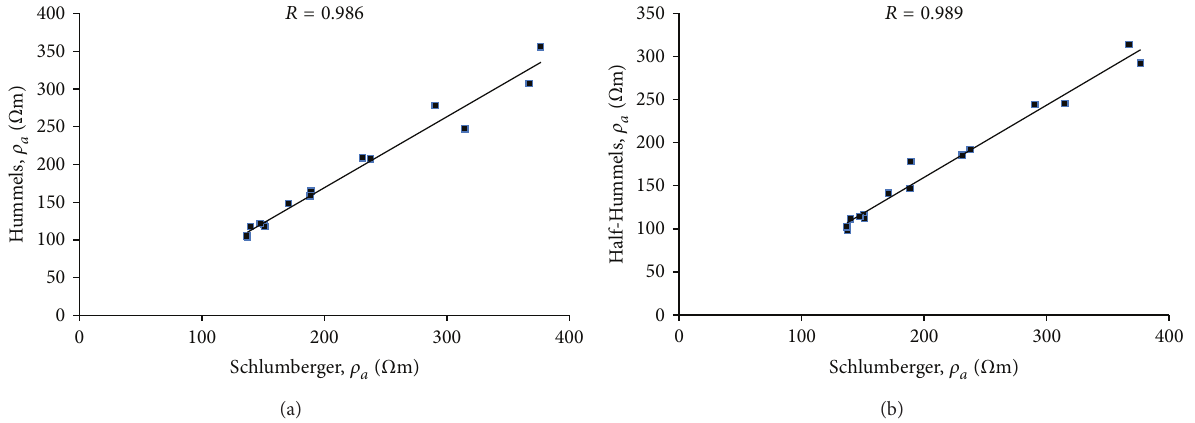
Figure 21: Statistical plot of apparent resistivity data for location 22 (augen gneiss) (a) Hummel against conventional Schlumberger (VES) and (b) “Half-Hummel” against conventional Schlumberger (VES).